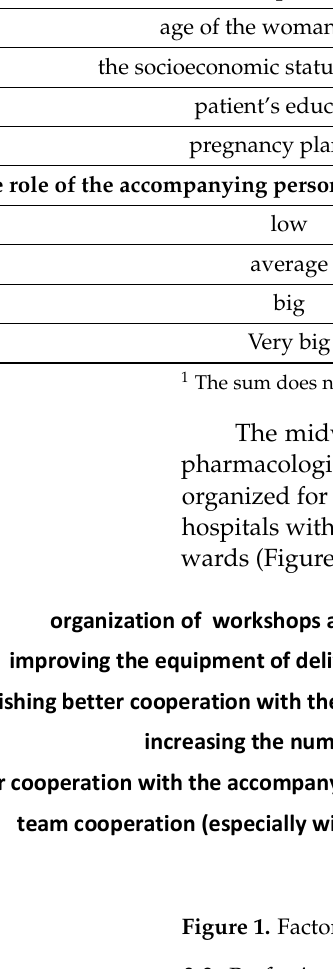
Table 3. Education of surveyed midwives versus the use of non-pharmacological methods of reliev- ing labor pain and assessment of the degree of preparation for the use of vertical positions. The Use of Vertical Positions